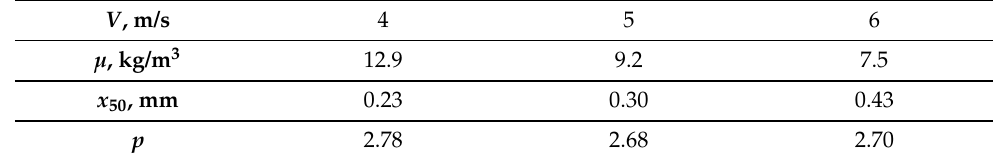
Table 4. Fine size recovery parameters for magnetic separation waste.